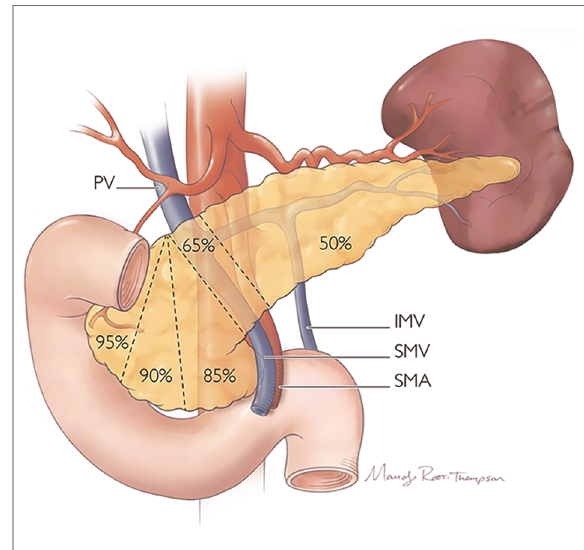
FIGURE 12 Proportions of the pancreas which may be resected during radical or parenchyma-preserving